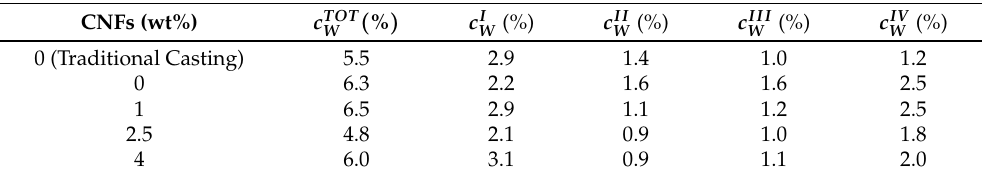
Figure 3. TGA curves: weight loss % (top) and derivative weight loss (%/ ◦ C) (bottom) of specimens with different CNF dosages after 7 days at RH = 77. Table 2. Water content (%) of the distinct water populations confined in the specimen obtained by TGA